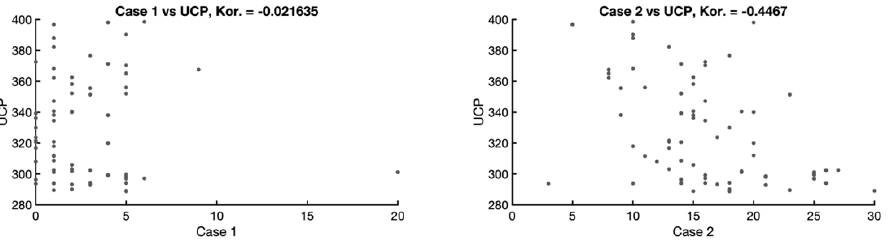
Figure 5. Correlation between use cases and real size in UCP. A similar situation can be seen when looking at the actors (Figure 6), whereby the strongest dependency can be seen between the attribute Actor 3 and the attribute UCP ( − 0.59). Dataset DS contains, to a large extent, regular company software systems in which actors are included in groups of complex actors that, to a greater degree, occur naturally. The relationship between the weights T1–T13 and E1–E8 is not captured because it has no practical significance for further analysis. Figure 6. Correlation between actors and real size in UCP. In the studied Dataset attributes, a relationship with the real size of the software systems (UCP) was demonstrated. In the case of some attributes of the UCP method, the relationship is weak (TCF, ECF). Some groups of actors and use cases (Actor 1, Actor 2, Case 1 and Case 3) also have a weak relationship. However, this can be described as a